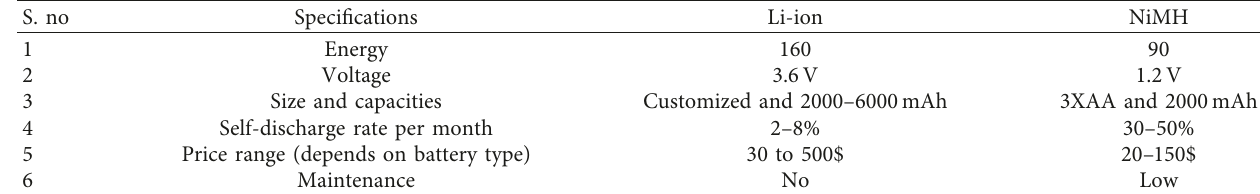
Table 1: Comparison of Li-ion vs